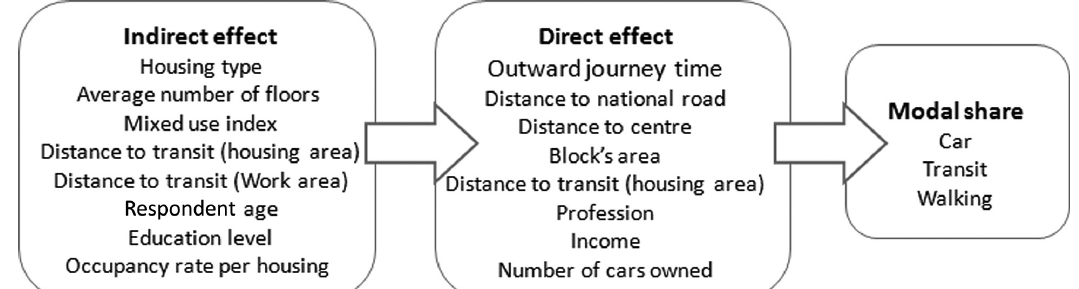
fig. 9. Hypothetical causal pathways between variables and modal